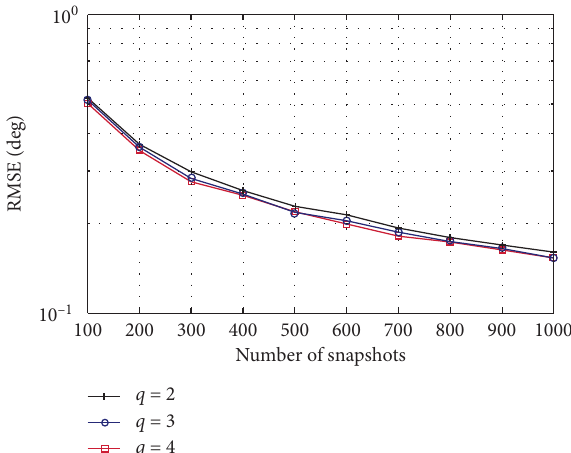
Figure 9: RMSE of the proposed algorithm with different q versus snapshots.